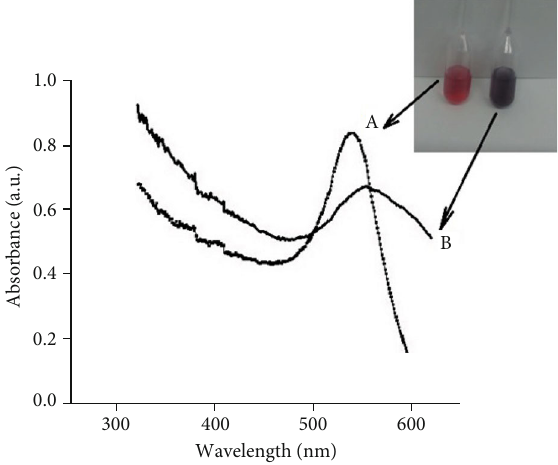
Figure 3: UV-vis spectra of the gold nanoparticle solution: (A) before and (B) after the immersion of plasma-treated PET fi